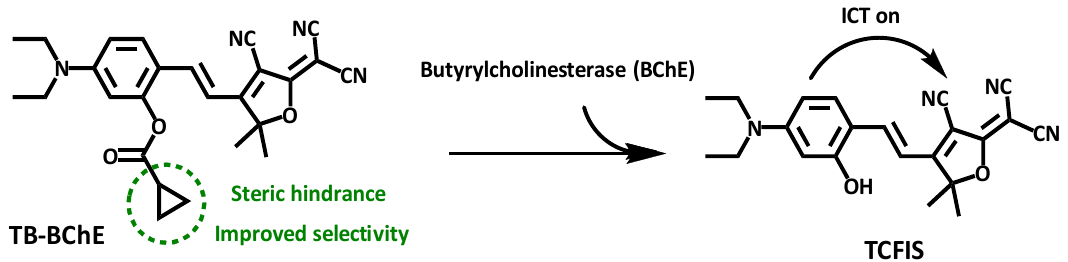
Figure 17. Structure and response mechanism of HBT-BChE to butyrylcholinesterase (BChE). Chen and coworkers developed another probe, HBT-BChE , to visualize the BChE in